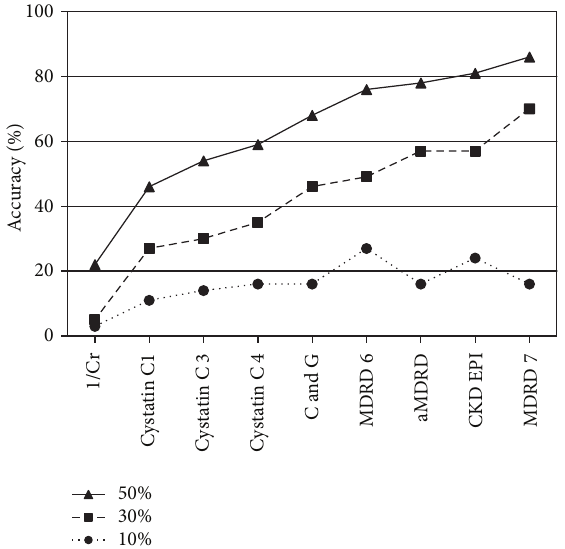
Figure 2: The accuracy of each of the equations expressed as the percentageofestimateswithin10%,30%(P 30 ),and50%ofthe 4